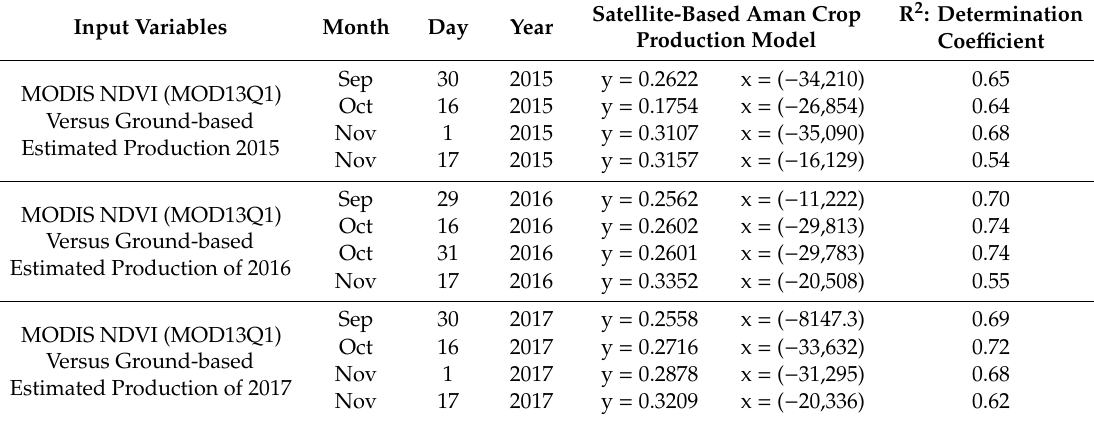
Table A2. Comparative statistical analysis of RS Model and BBS estimated Aman production (2011–2017). Aman Rice Production Year